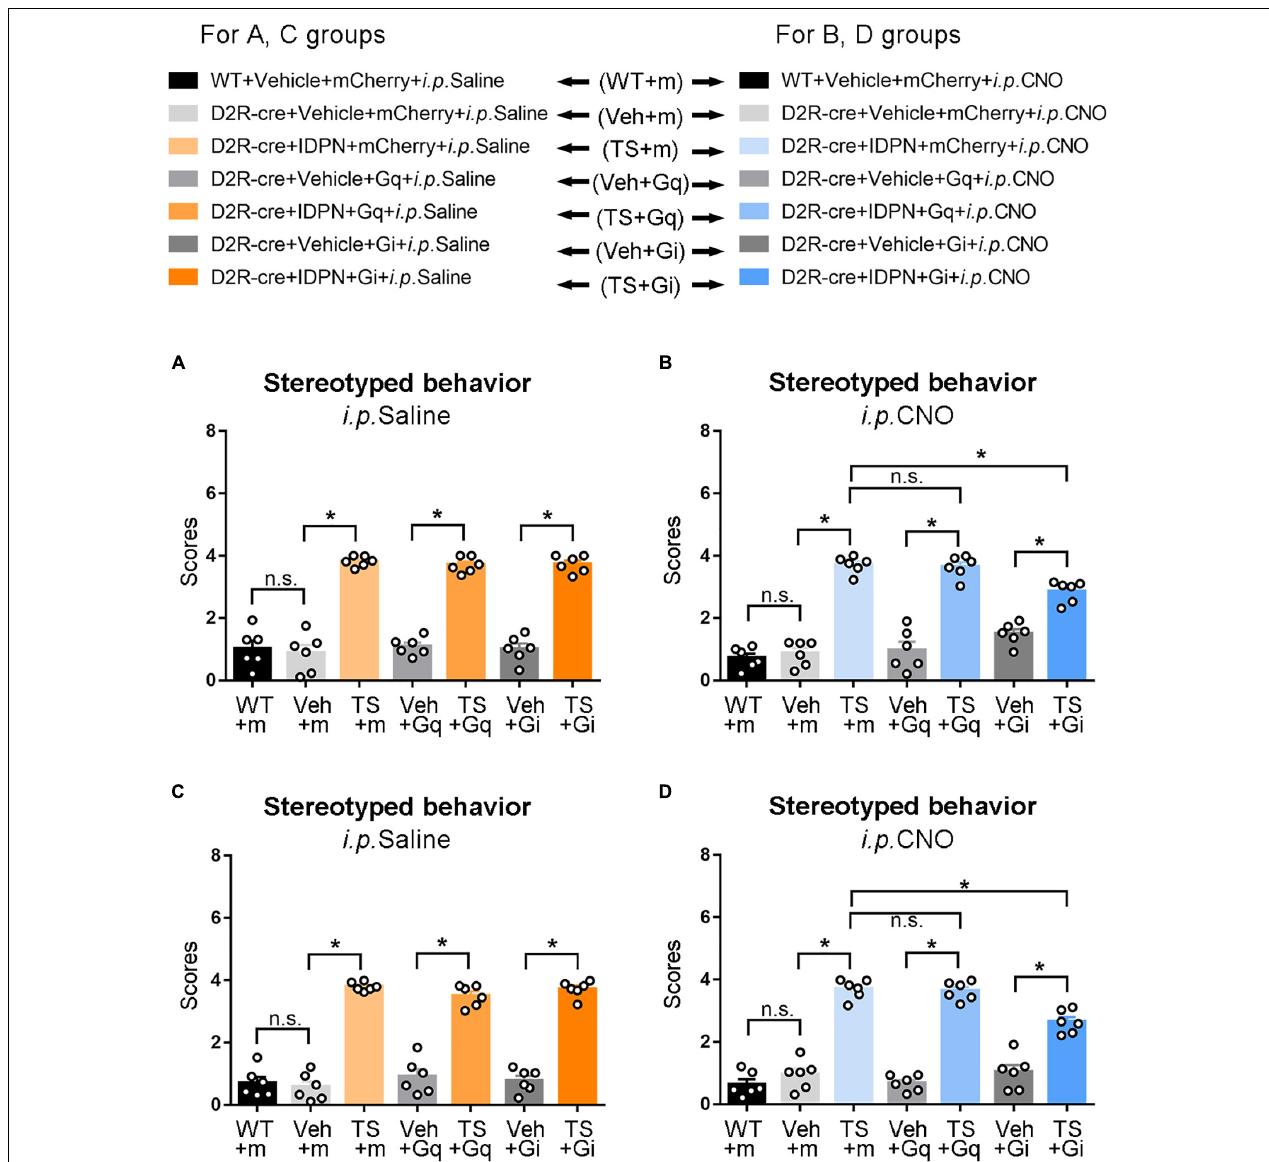
FIGURE 5 | Effects of activation or inhibition of the D2R-containing neurons in the SNpc and dSTR on stereotyped behavior in mice. (A) Evaluations of stereotyped behavior scores of mice injected with virus in the SNpc 30 min after the injection of saline (i.p. Saline) in the WT + Vehicle + mCherry + i.p. Saline group (WT + m), D2R-cre + Vehicle + mCherry + i.p. Saline group (Veh + m), D2R-cre + IDPN + mCherry + i.p. Saline group (TS + m), D2R-cre + Vehicle + Gq + i.p. Saline group (Veh + Gq), D2R-cre + IDPN + Gq + i.p. Saline group (TS + Gq), D2R-cre + Vehicle + Gi + i.p. Saline group (Veh + Gi), D2R-cre + IDPN + Gi + i.p. Saline group (TS + Gi) on day 23. (B) Evaluations of stereotyped behavior scores of mice injected with virus in the SNpc 30 min after the injection of CNO (i.p. CNO) in the WT + Vehicle + mCherry + i.p. CNO group (WT + m), D2R-cre + Vehicle + mCherry + i.p. CNO group (Veh + m), D2R-cre + IDPN + mCherry + i.p. CNO group (TS + m), D2R-cre + Vehicle + Gq + i.p. CNO group (Veh + Gq), D2R-cre + IDPN + Gq + i.p. CNO group (TS + Gq), D2R-cre + Vehicle + Gi + i.p. CNO group (Veh + Gi), D2R-cre + IDPN + Gi + i.p. CNO group (TS + Gi) on day 23. (C) Evaluations of stereotyped behavior scores of mice injected with virus in the dSTR 30